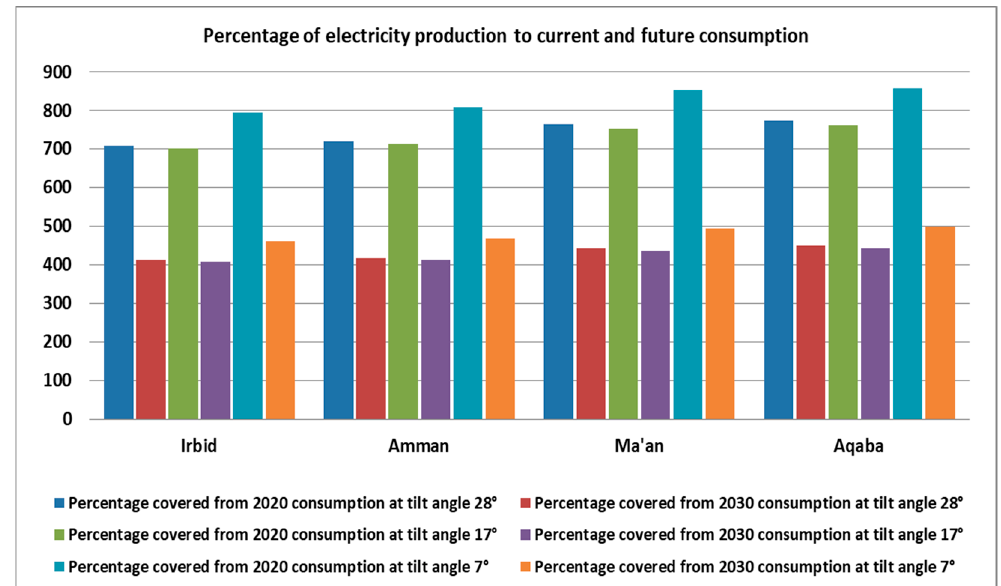
Figure 10. A comparison between electricity production from the installation of PV systems on the rooftops of single houses in relation to its current and future energy consumption.